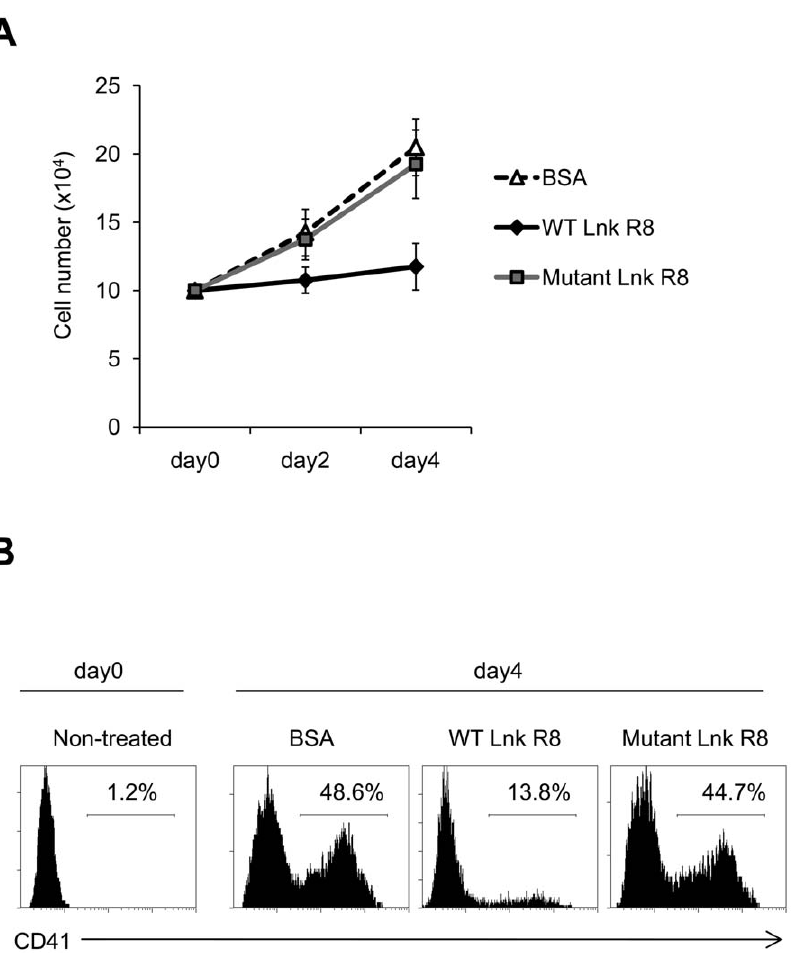
Figure 9. WT, but not mutant Lnk R8 blocks TPO-induced megakaryopoiesis. (A) CD34 + cells were treated with WT, mutant Lnk R8 or BSA as described in Materials and Methods and cultured for 4 days in the presence of TPO. Viable cell numbers were determined by trypan blue exclusion every two days. (B) BSA or Lnk R8 proteins treated-CD34 + cells were subjected to flow cytometry analysis of CD41 + megakaryocytes at day 0 and day 4 after TPO addition. (Data represent one experiment of two independent